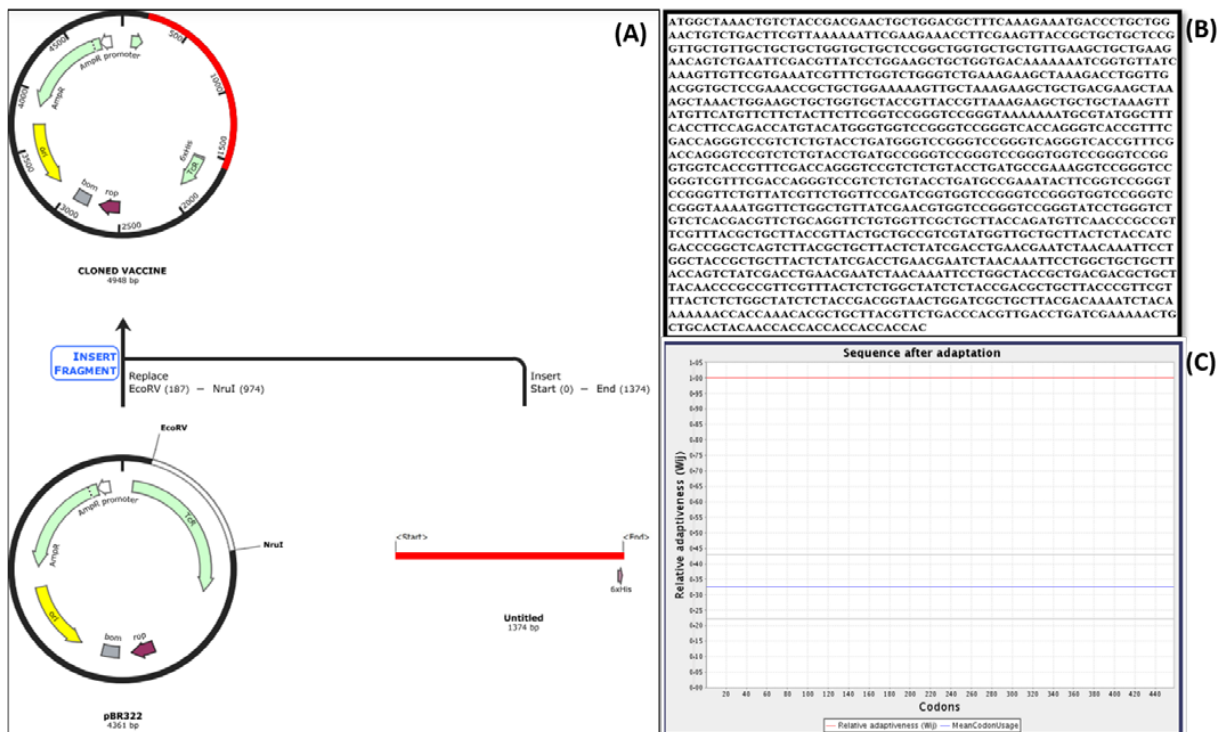
Figure 9. ( A ) Cloning process of vaccine into pBR322, ( B ) refined sequence according to codon op- timization, ( C ) codon adaptation postoptimization. optimization, ( C ) codon adaptation